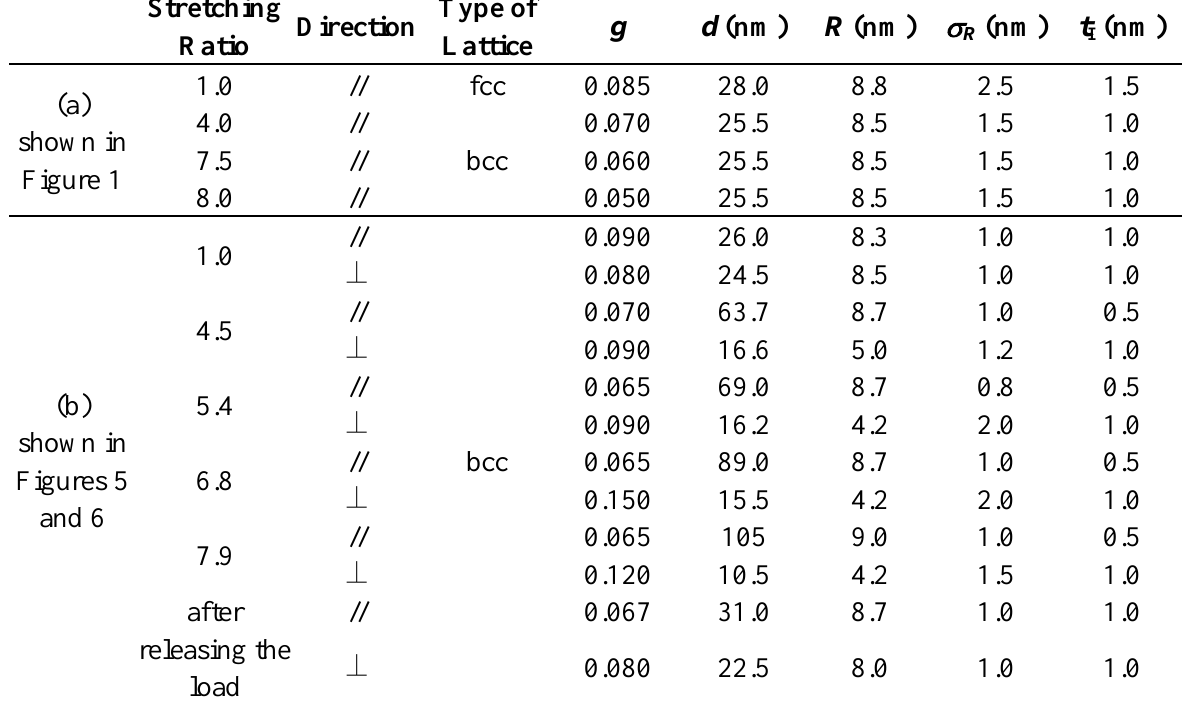
Table 1. Values of structural parameters used for the SAXS profiles based on the fcc and bcc paracrystalline models.